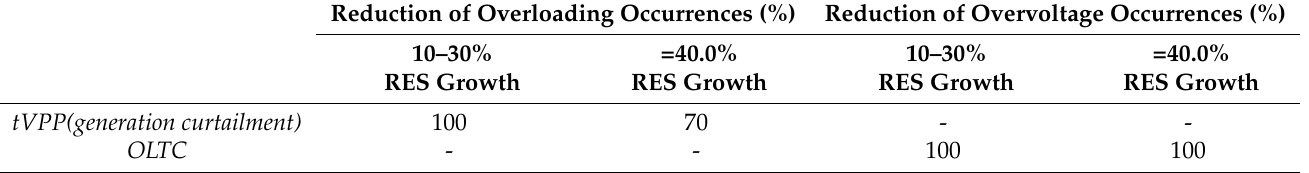
Table 3. KPIs—Slovenian overloading and overvoltage